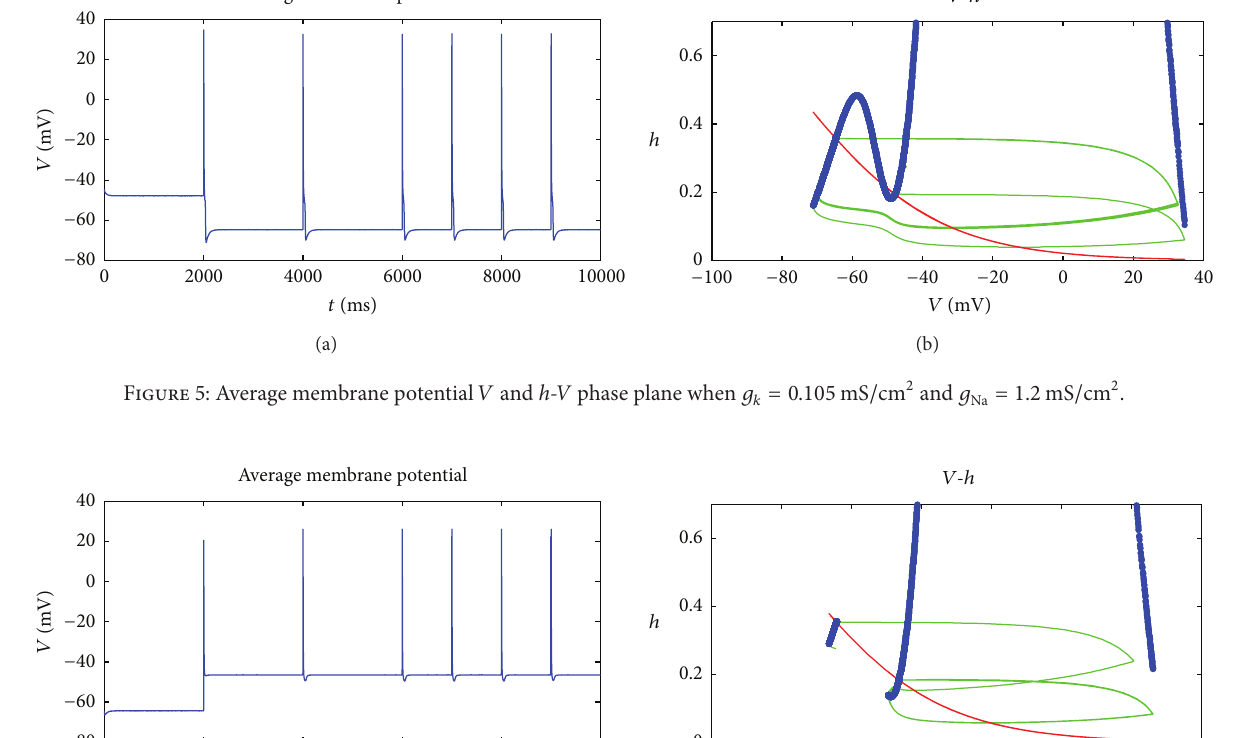
Figure 6: Average membrane potential 𝑉 and h-V phase plane when 𝑔 𝑘 = 0.1 mS / cm 2 and 𝑔